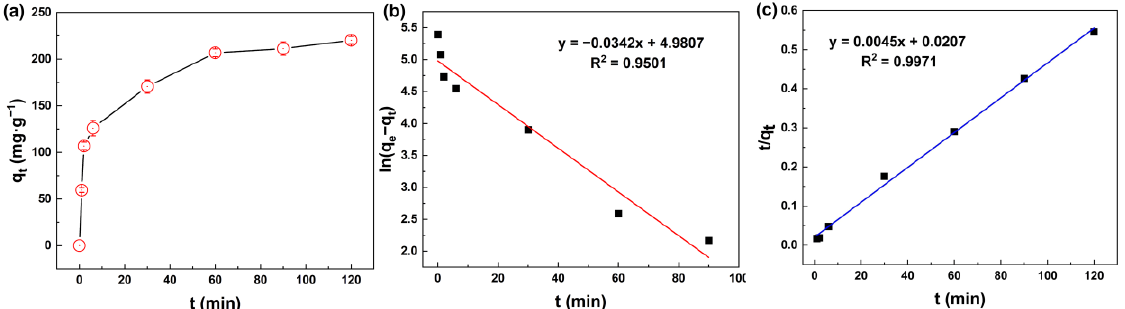
Figure 5. ( a ) Adsorption capacity of silicic acid as a function of time; ( b ) Linear fit using the pseudo-first-order model; ( c ) Linear fit using the pseudo-second-order model. Table 1. Kinetic parameters of silicic acid adsorption process.